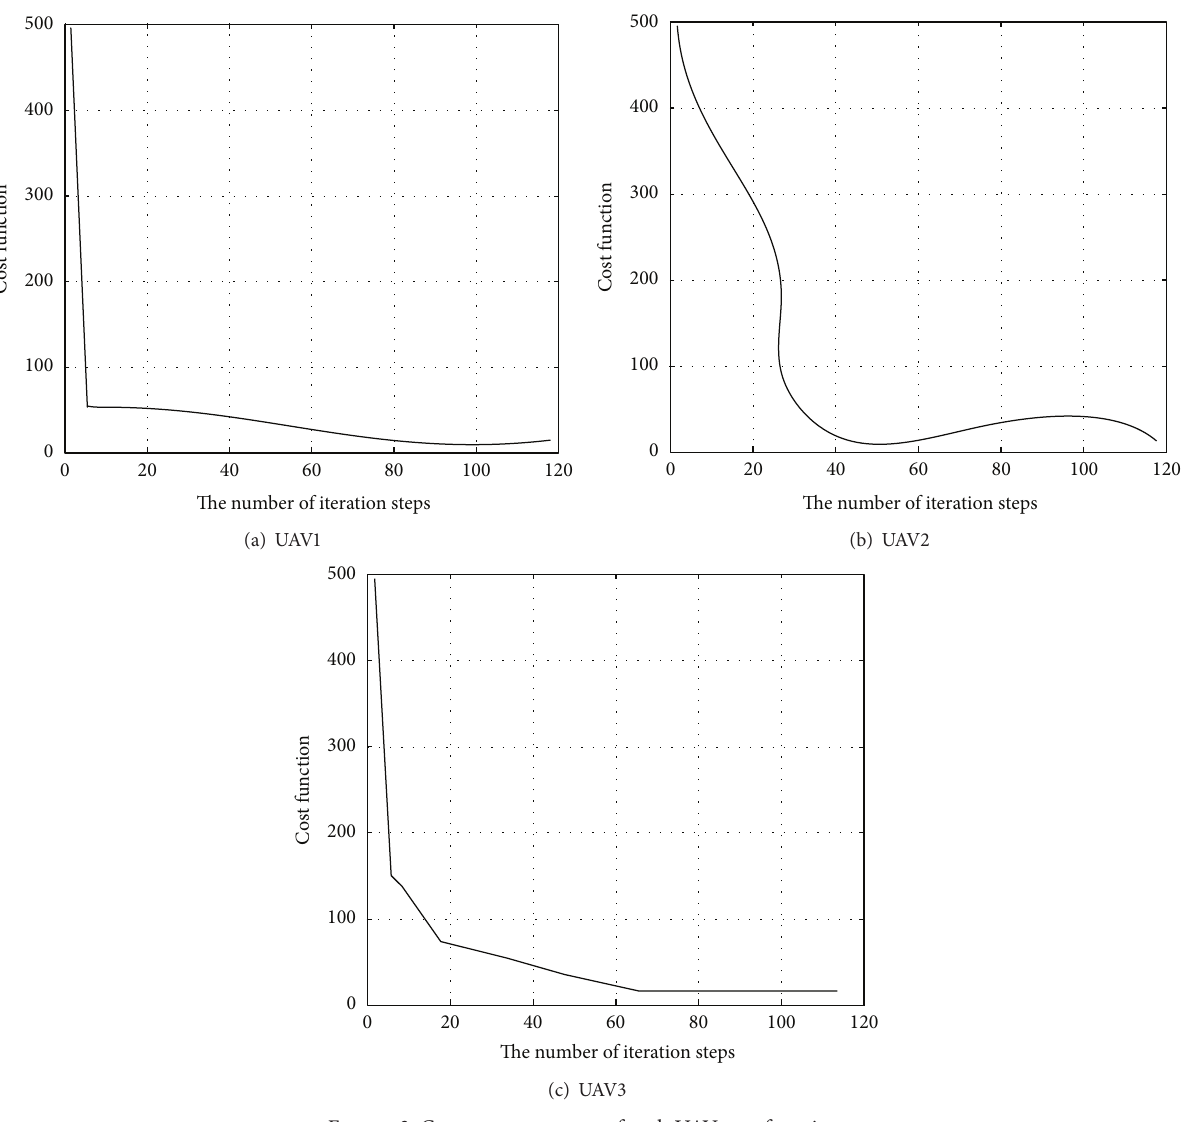
Figure 3: Convergence curves of each UAV cost